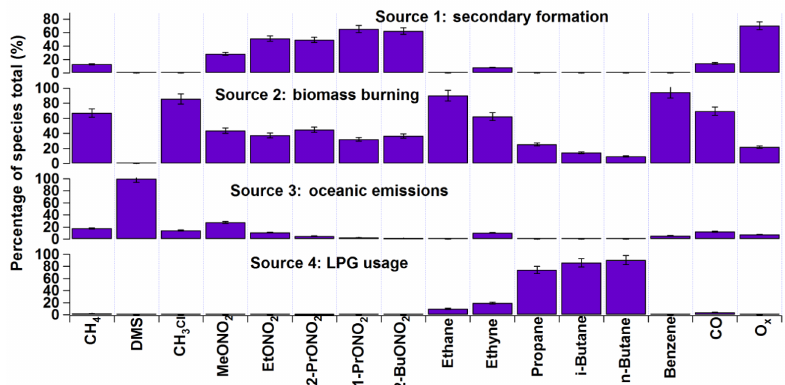
Figure 7. Explained variations of species in the identified sources extracted by the PMF model for